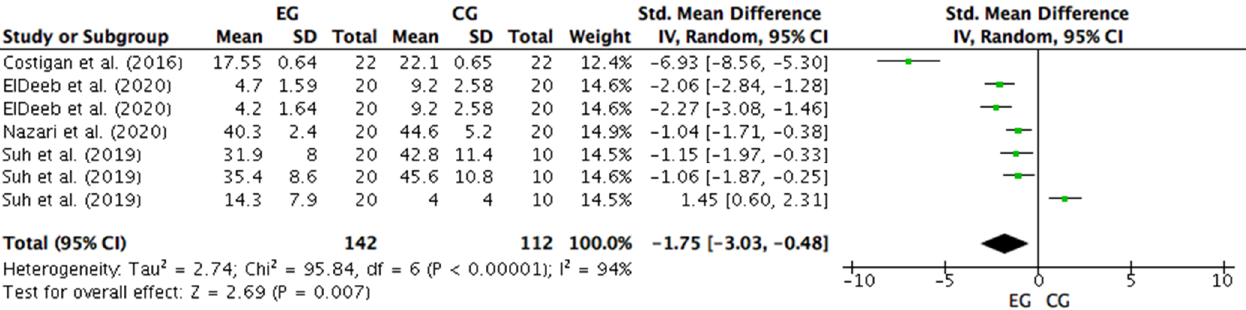
Figure 5. Forest plot comparing the effects of training with different modes of strength intervention on anxiety levels. EG: experimental group; CG: control group; SD: standard deviations.